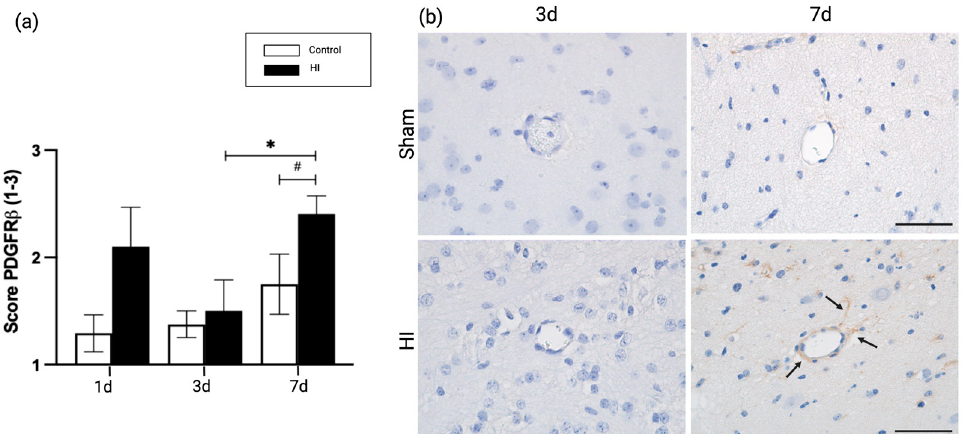
Figure 4. Pericyte coverage surrounding brain microvasculature. ( a ) Qualitative scoring of PDGFR β at 1, 3 and 7 days post HI or sham; ( b ) Representative microscopic images of PDGFR β in the microvasculature at 3 and 7 days sham and HI treatment. Arrows indicate pericytes surrounding capillaries at 7d HI. Statistical analysis was performed using a Kruskal-Wallis test followed by Dunn’s post hoc test. Bars represent mean ± SEM. Scale bar 50 µ m. 400 × magnification * p < 0.05, # p = 0.06.